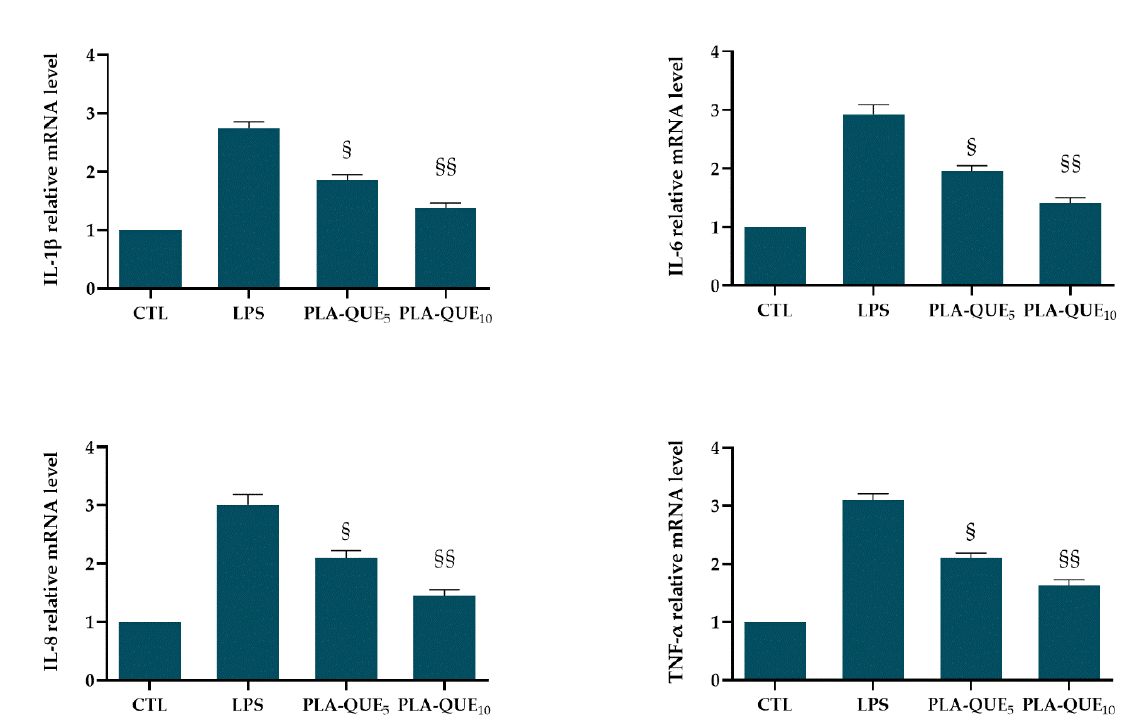
Figure 6. Effects of released QUE on mRNA levels of IL-1 β , IL-6 , IL-8 and TNF- α in LPS-stimulated HGFs. HGFs were pre-treated with PLA-QUE membranes for 24 h, followed by LPS stimulation (final concentration at 1 µg/mL) for 3 h. The values of three independent experiments are presented as means ± SD. § p < 0.05 and §§ p < 0.01 versus LPS.